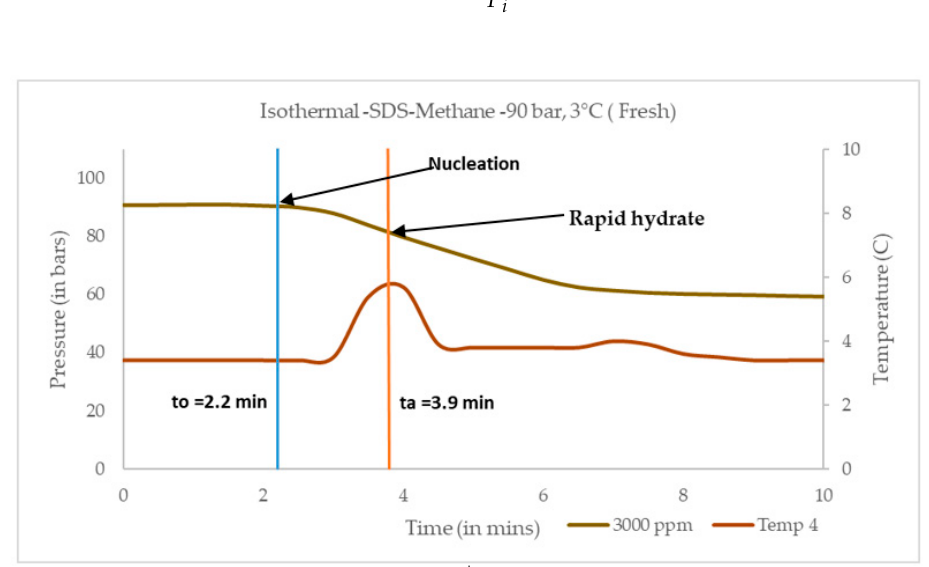
Figure 5. Graphical representation of the method adopted to demonstrate how to calculate t o and t a .